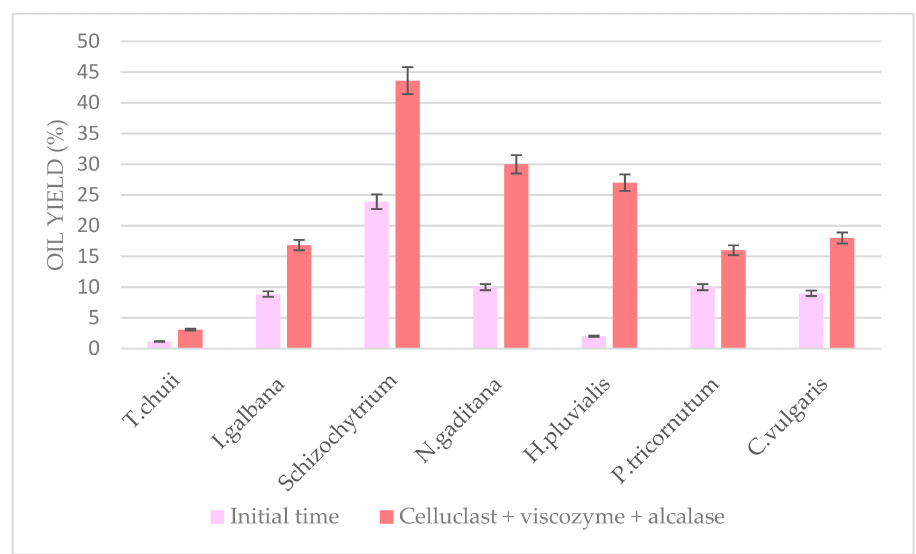
Figure 9. Schizochytrium spp., I. galbana , T. chuii , C. vulgaris , H. pluvialis , P. tricornutum , and N. gaditana biomass oil yield obtained at initial time and after the optimal US-assisted combined enzymatic